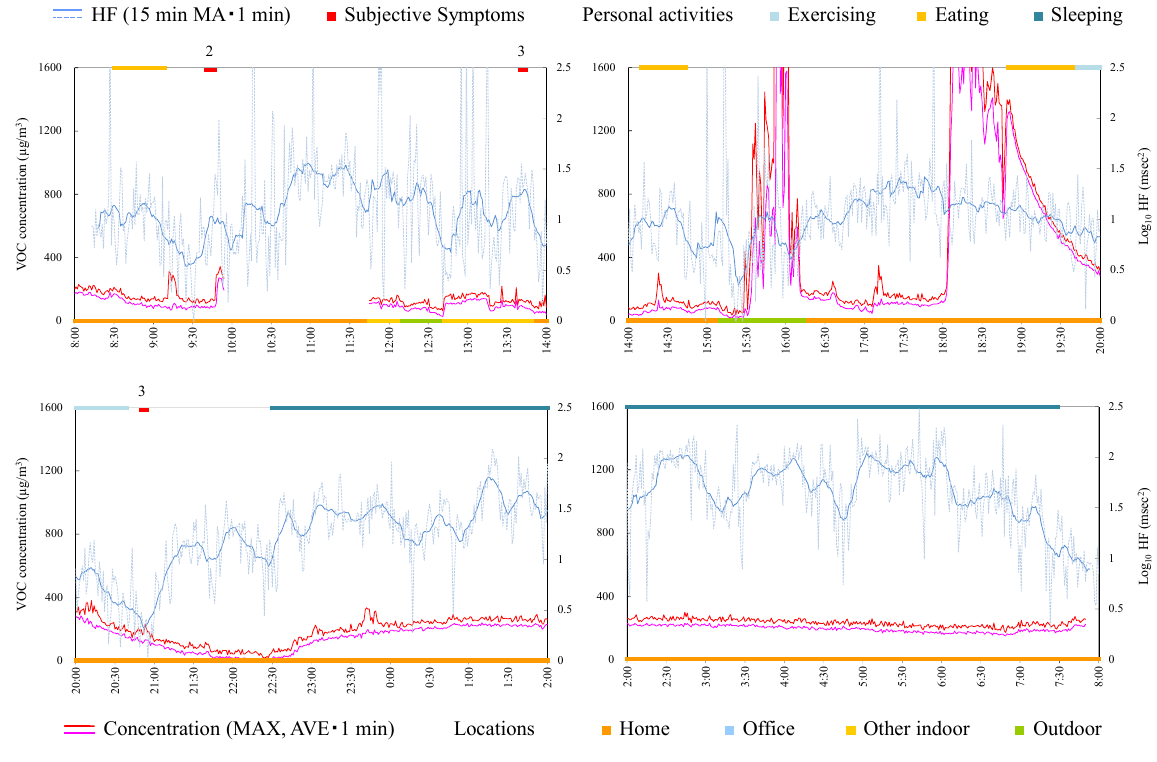
Figure 8. Time-series data of VOC concentration and log 10 HF (subject F). Subjective symptoms and personal activities are indicated in upper side and locations are indicated in lower side. The values on subjective symptoms are symptom